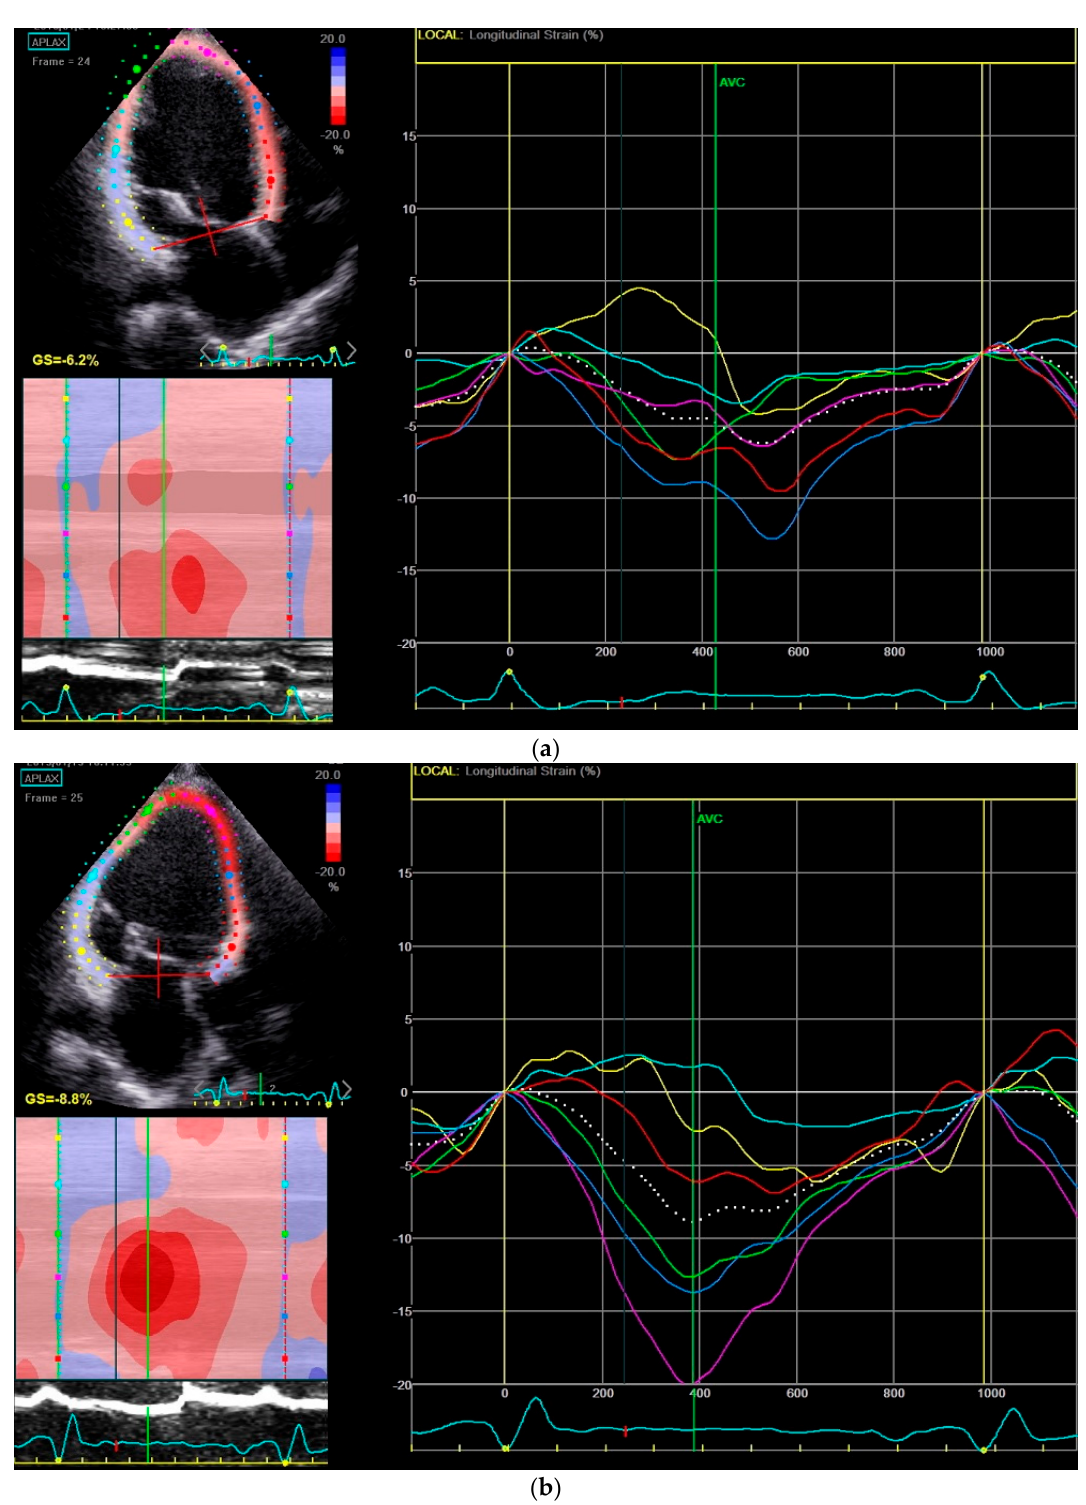
Figure 1. Mechanical dispersion index reduction before ( a ) and after ( b ) six months of Sacubitril-Valsartan ( LCZ696) therapy in a patient with an ischemic cardiomyopathy in the APLAX view.